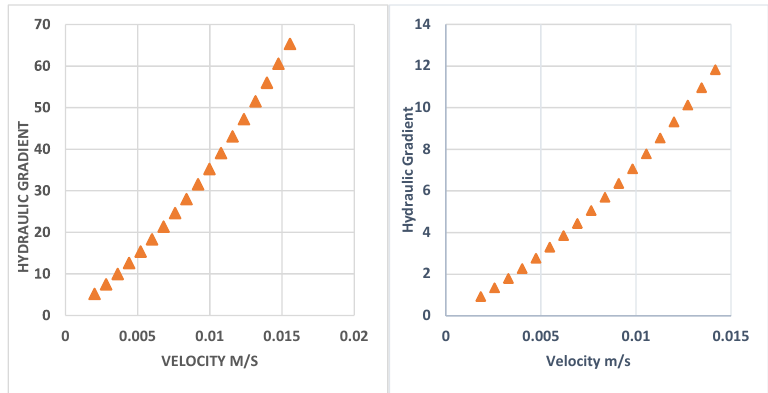
Figure 4. Hydraulic Gradient vs. Velocity for samples 1 and 2 respectively.